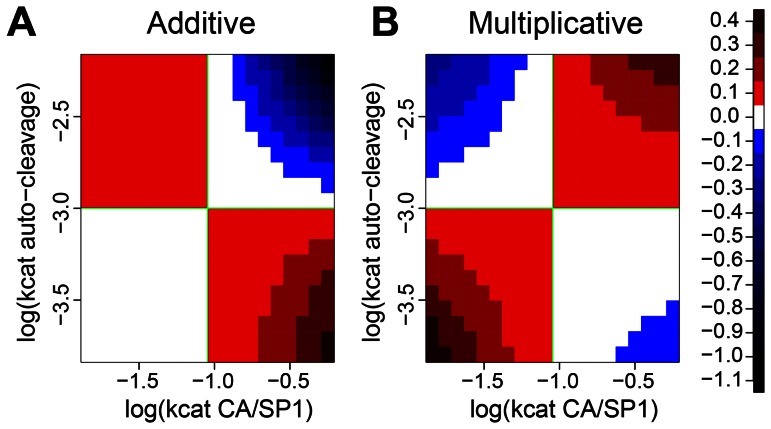
Accuracy of predicting combined parameter effects on VMT assuming additive (A) and multiplicative (B) interaction.Simulations were run with a geometric series of 20 values ranging from 0.16 to 6.25 times the default for both parameters, and with all 400 combinations of the variants. Under the additive model, predictions of combined effects were obtained by adding up absolute changes in VMT observed when changing each of the parameters separately; predictions under the multiplicative model were obtained by multiplying the relative (fold change) individual effects. Deviations (in minutes) from both predictions are plotted with color-coding; the dimensions of both parameters were s−1. The additive model performs better (smaller deviation) when both parameters are increased or both are decreased; the multiplicative model performs better when one parameter is increased and the other decreased.